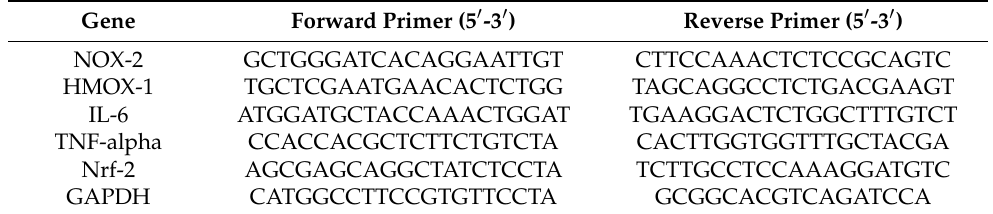
Table 2. Primers used in this study. Annealing temperature was 60 ◦ C for all transcripts.